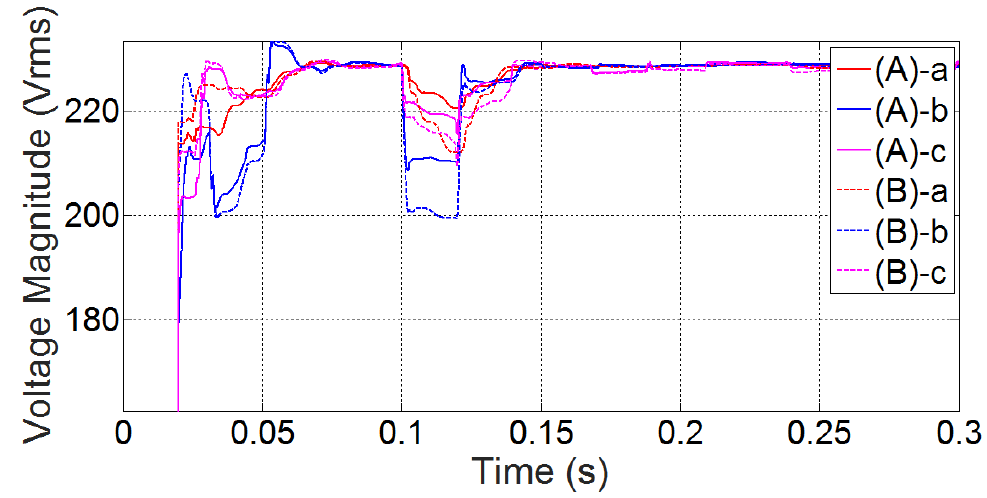
Figure 9. Voltage Magnitude per phase and microgrid in mode interconnected and grid-islanded.